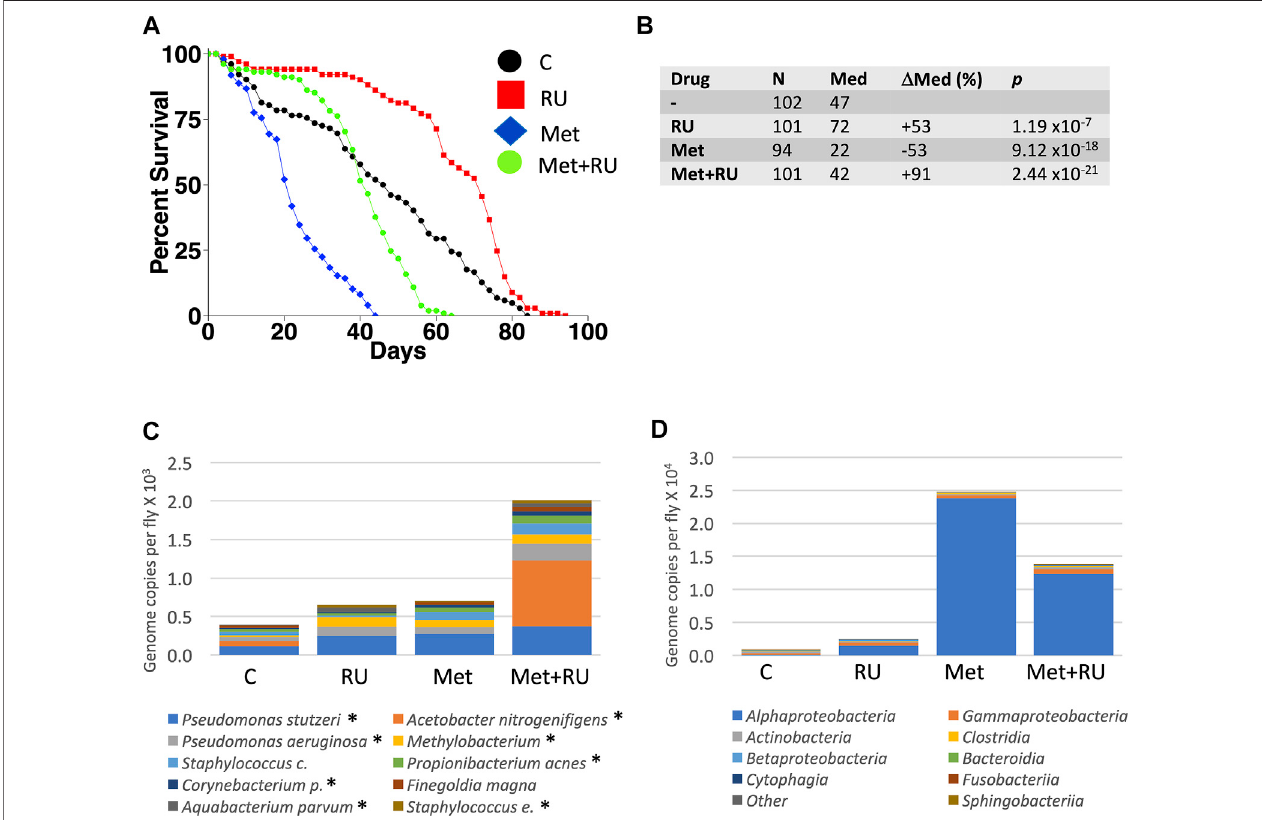
FIGURE 4 | Effect of methoprene and mifepristone on virgin female life span, bacterial species, and classes. (A) Survival curves. C, minus-drug control; RU, mifepristone;andMet,methoprene.DataarereplottedfromLandisetal.(2021a). (B) Lifespanstatisticalsummary.Percentchangeinmedianlifespanwascalculatedby comparing RU to C, and by comparing Met to C, and by comparing Met + RU to Met. Statistical test: log-rank; p- value for signi fi cance with three comparisons is 0.017. (C) Average top ten species (excluding outliers). (D) Average top ten classes (excluding outliers). C, control; RU, mifepristone/RU486; and Met, methoprene. For both species and classes, no statistically signi fi cant differences were detected between groups using Kruskal – Wallis test. Species and classes reported to be aero- tolerant are indicated with asterisk.